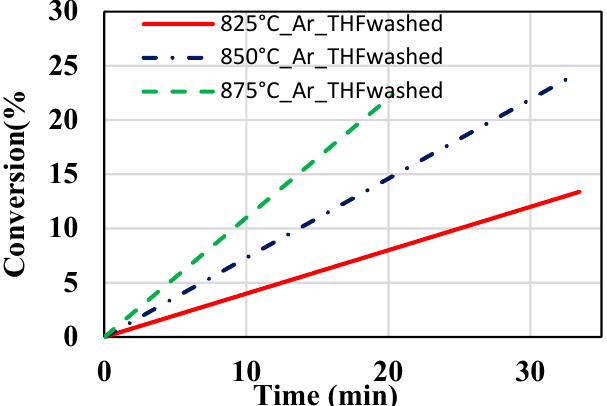
Figure 4 . Conversion profiles of chars with CO 2 in HPTGA (The temperature in the legend indicates the HPTGA temperature and the gas atmosphere indicates the pyrolysis atmosphere in a high- pressure, high-temperature flow reactor (HPHTFR)).